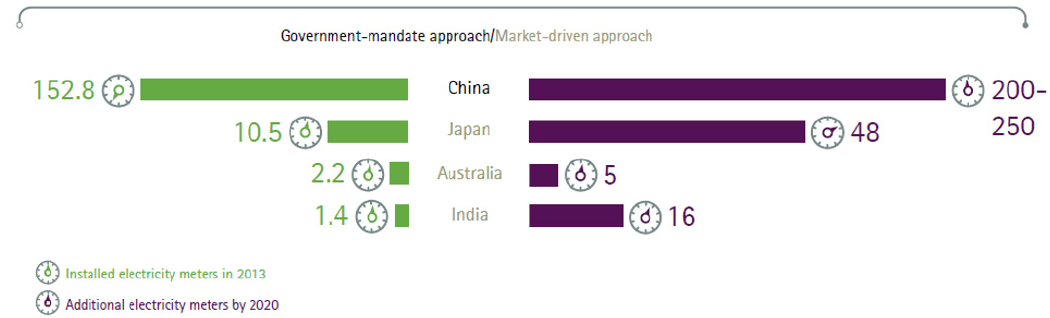
Figure 8. Estimation of the total number of SM s in installed Asia ‐ Pacific countries by 2020 (Source: Accenture [55]). Reprinted with the permission of Accenture, “Realizing the Full Potential of Smart Metering ”, published by Accenture, 2015.